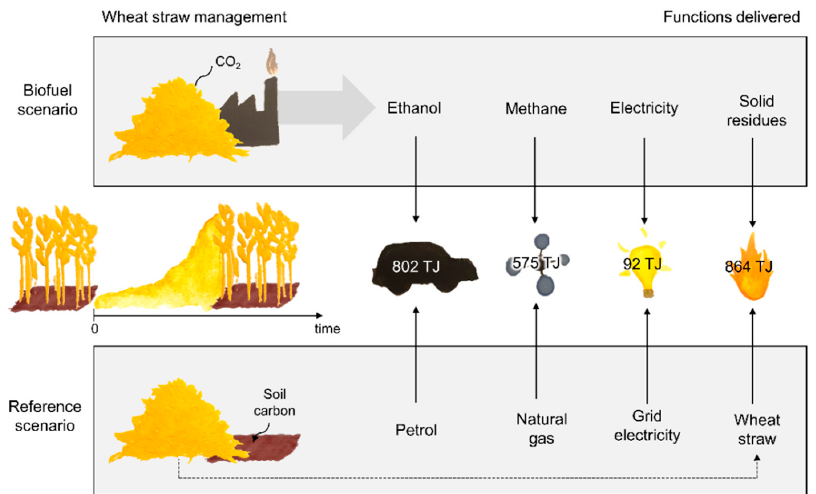
Figure 2. Schematic description of the biofuel scenario for wheat straw (top), and the functionally equivalent reference scenario (bottom). The scenarios depart from the same agricultural practice and deliver the same functions but differ in terms of how straw is managed (utilization for biofuel production or leave at the site) and how the functions are provided (from biomass, or fossil fuels and grid electricity). The broken arrow illustrates that a part of the straw is used for heating in the reference